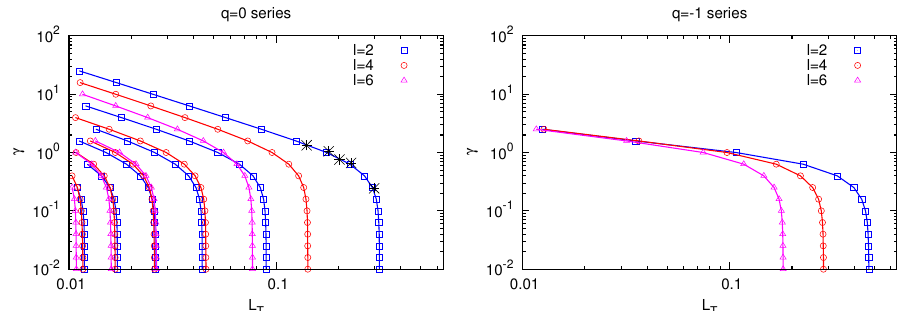
Fig. 2. Growth rates of aperiodic modes for series q = 0 (left) and q = − 1 (right) vs. parameter L T governing the angular momentum dispersion. The curves marked by signs correspond to different spherical harmonics, l = 2 , 4 , 6. The asterisk symbols show the results of N -body